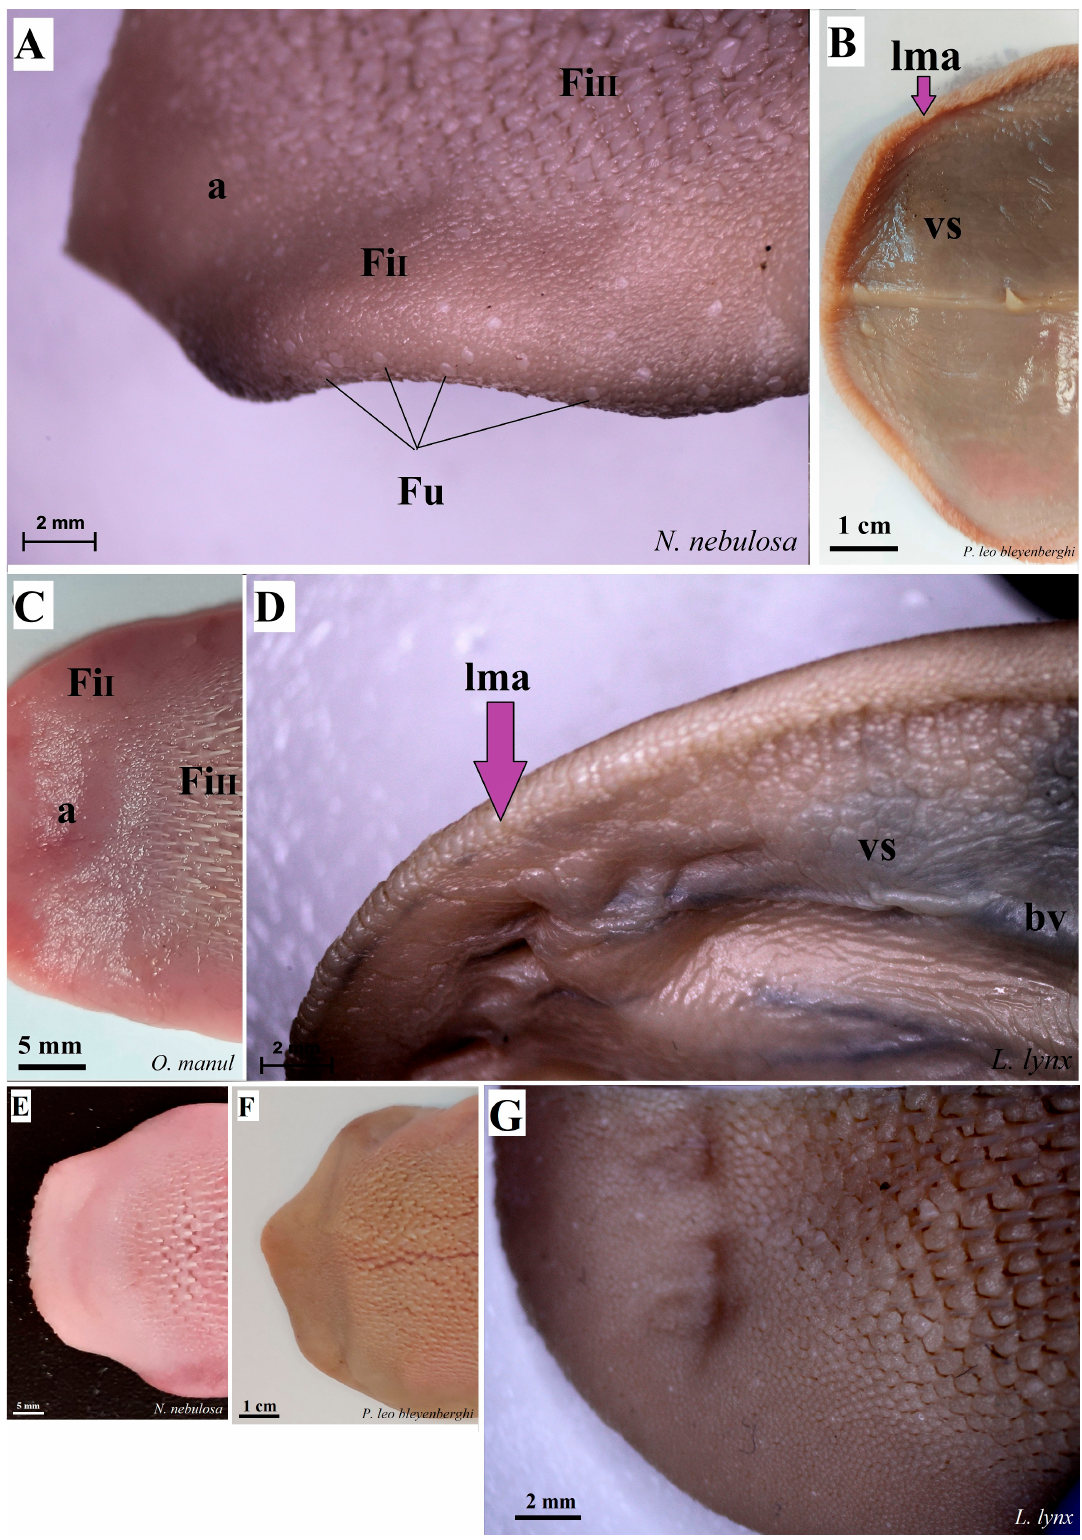
Figure 4. Stereoscopic view of the dorsal surface ( A , C , E , F , G ) and the ventral surface ( B , D ) of the lingual apex of N. nebulosa ( A , E ), P. leo bleyenberghi ( B , F ), O. manul ( C ) and L. lynx ( D , G ). Bar = 2 mm (A,D); bar = 1 cm (B); bar = 5 mm (C); bar = 2 mm (A,D). Abbreviations: a — apex of the tongue, bv — blood vessel visible on the ventral surface of the tongue, lma — lateral margin of the lingual apex (purple arrow), vs — ventral surface of the tongue.